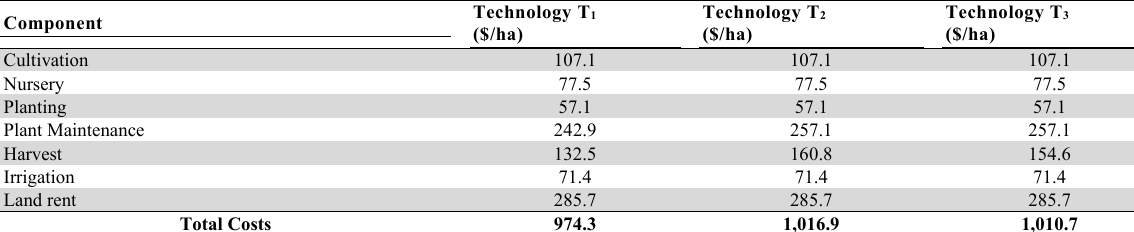
Cost Production of Rice Farming Based on Technological System